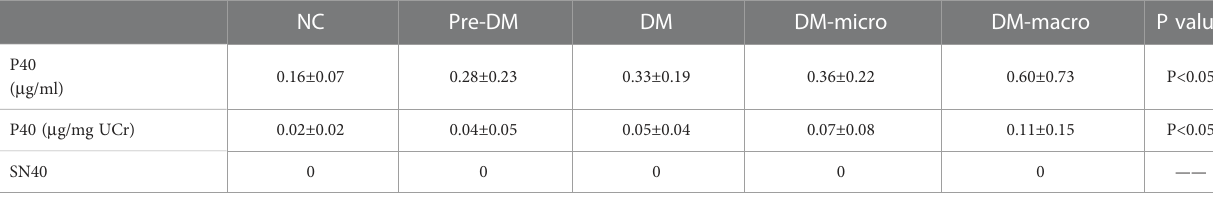
Protein concentration = Protein amount ( m g) / Original urine volume (ml). Protein concentration adjusted by Ucr = Protein amount ( m g) / urinary creatinine (mg). P40, Pellet 40,000 after 40,000g centrifugation; SN40, Supernatant 40,000 after 40,000g